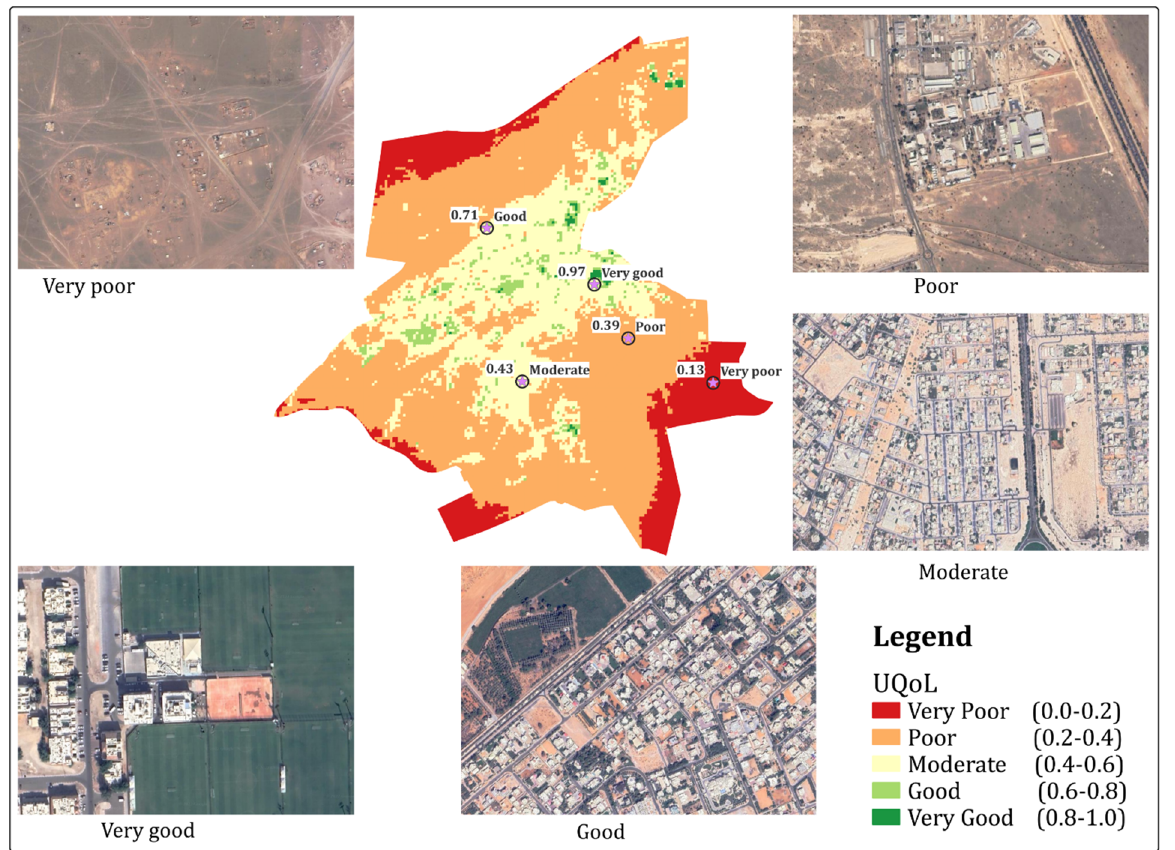
Figure 7. Visual inspection of UQoL index map. Table 6. Summary of the UQoL regression model.